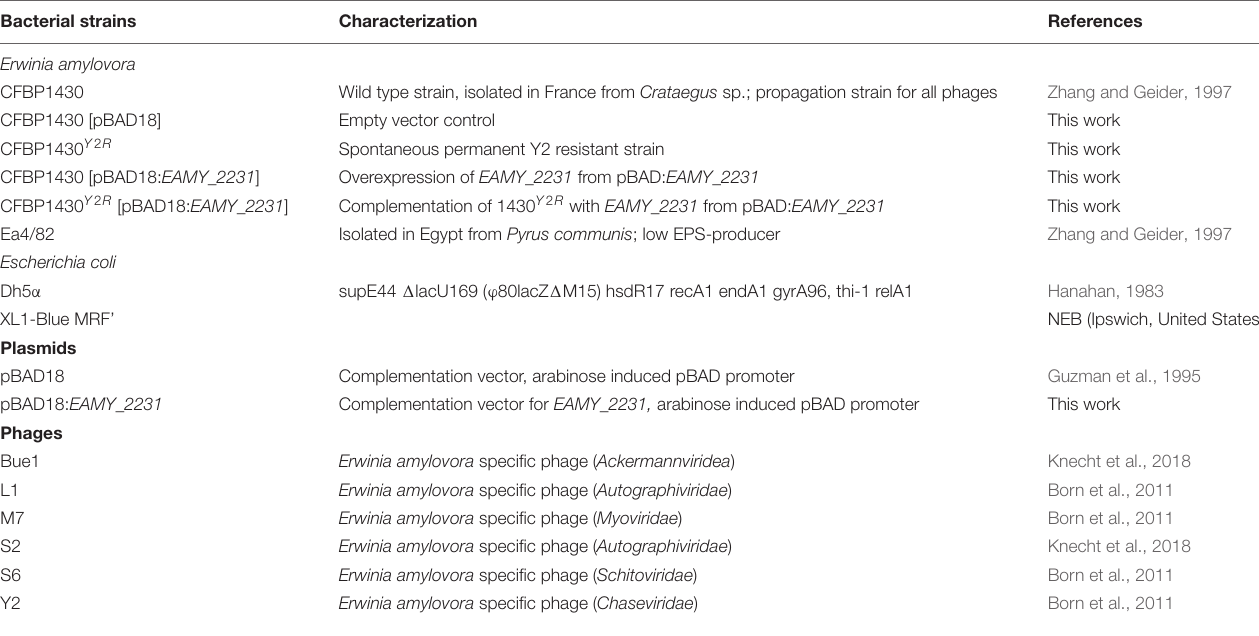
TABLE 1 | Table 1Overview of the used bacterial strains, generated mutants and applied phages. Bacterial